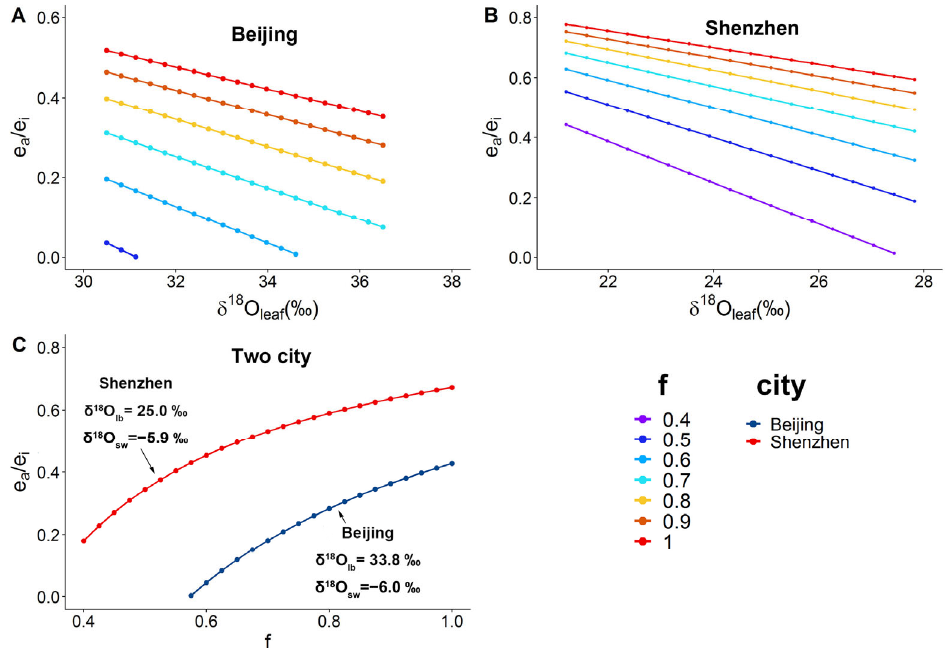
Figure 5. The relationship between δ 18 O in leaves and e a /e i under different values of ( A ) P. tomentosa leaves in Beijing, ( B ) F. virens leaves in Shenzhen. ( C ) Compared e a /e i between the two cities. The text in the figure shows the mean δ 18 O values, in source water and leaves, used in Equation (3). To compare the differences in e a /e i between the cities, the e a /e i were solved for the mean δ 18 O value in leaves and soil water. Figure 5C shows the trend of e a /e i . The e a /e i in Beijing and Shenzhen covers 0.01–0.43 and 0.18–0.67, respectively, showing that that of Beijing was significantly lower than Shenzhen’s (Wilcoxon rank sum test, W = 52, p <